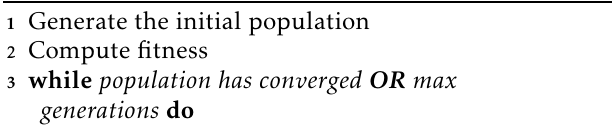
Algorithm 1: Fundamentals on GA meta-